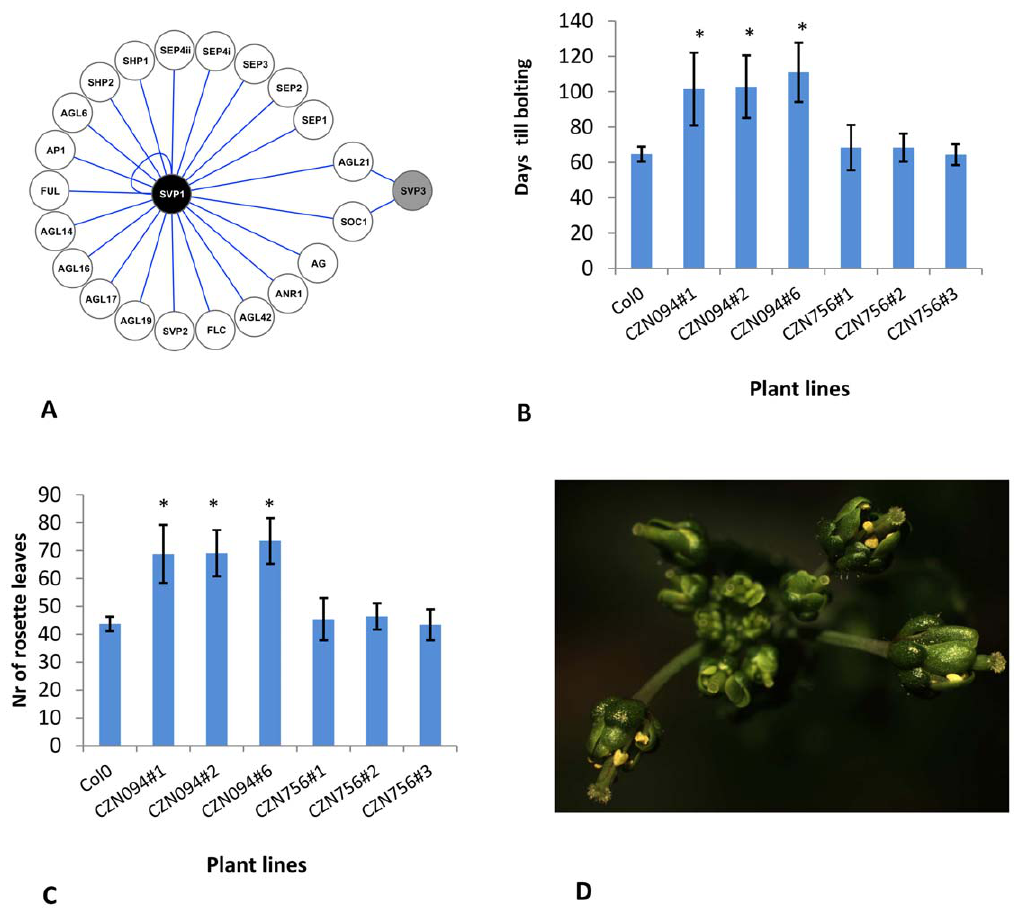
Figure 2. Functional analysis of two SHORTVEGETATIVEPHASE(SVP) isoforms. A ) Graphical representation of protein-protein interaction capacity of the SVP1 (black) and SVP3 (grey) splicing variants as determined by matrix-based yeast two-hybrid studies (Van Dijk et al, 2010). B ) and C ) Effect of ectopic expression of SVP1 (CZN094) and SVP3 (CZN756) on flowering-time under short day conditions. Flowering-time was assessed using days until bolting ( B ) as well as the number of rosette leaves ( C ). For both constructs, flowering-time of three segregating lines was analyzed and compared to flowering-time of wild type control plants. * denotes statistical significance with p , 0.01 ( t -test). D ) Floral phenotypes upon ectopic expression of SVP1 . First and second whorl organs are greenish and leaf-like and flowers are partially sterile due to reduced anther filament elongation.